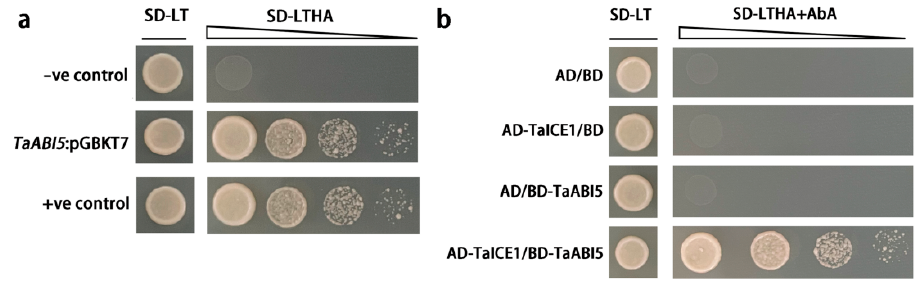
Figure 10. Y2H assay of interaction between TaICE1 and TaABI5. ( a ) Transcription activation assay of TaABI5 in yeast. ( b ) TaICE1 and TaABI5 were co-transformed into yeast. Colonies were assayed for SD/-Leu-Trp autotrophy and SD/-Leu-Trp-His-Ade with 40 mM Aureobasidin (AbA) autotro- phy.